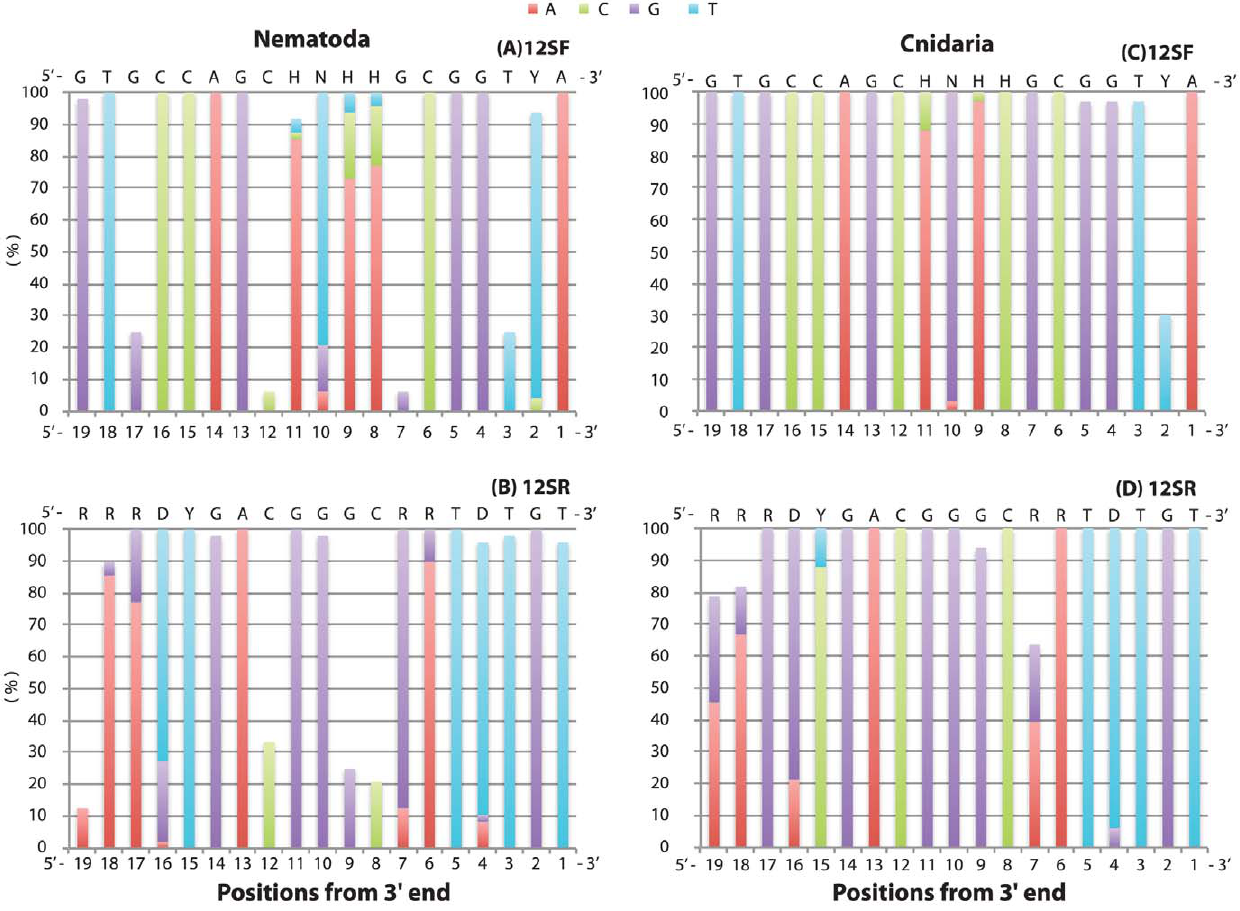
Figure 2. Nucleotide composition of the primer target regions observed in Nematoda (A and B) and Cnidaria (C and D). Sequences of the primers are indicated on top of each figure. The nucleotides that matched with the primers are shown stacked in each column. Position of each site from 3 9 to 5 9 is indicated on bottom from left to right.